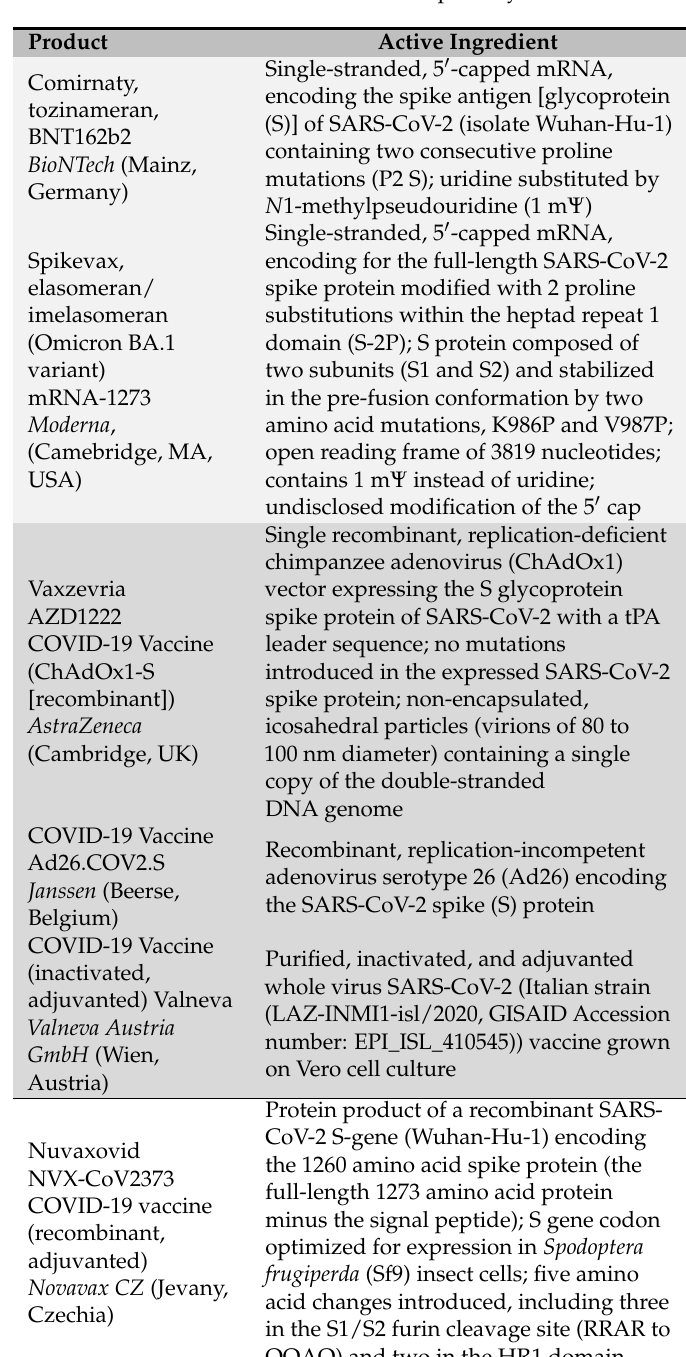
Table 3. Active ingredients and formulations of mRNA and viral-based COVID-19 vaccines ap- proved in the European Union. Data have been retrieved from the European Public Assessment Report (EPAR). The structural modifications provided in Table 3 do not reflect all changes that have been introduced into the mRNA molecules; major portions are proprietary and have not been disclosed